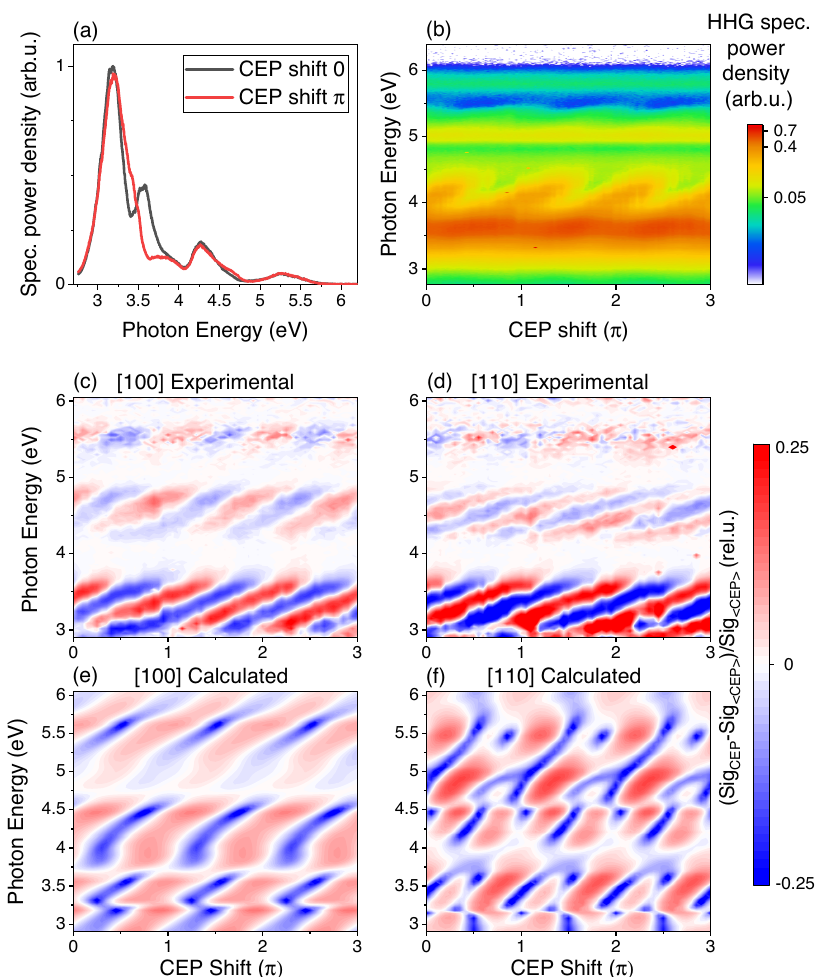
Fig. 3 Carrier-envelope phase (CEP) dependence of re fl ective high harmonic generation (HHG) in silicon. a Comparison of high harmonic spectra generated in crystalline silicon for linear polarization of the driving pulses along [100] direction for two values of CEP shifted by π . b CEP-dependent HHG spectra (color bar shows the spectral power density) with driving polarization along [100] direction. c , d Measured and e , f calculated HHG spectra for two directions of linear polarization of the driving pulse along c , e [100] and d , f [110] directions. The photon energy of the pulse was normalized in the time- dependent density functional theory (local density approximation) calculations to account for the underrated width of the band gap of E LDA color scale represents the relative difference between spectral power densities of the CEP-dependent and CEP-averaged high harmonic